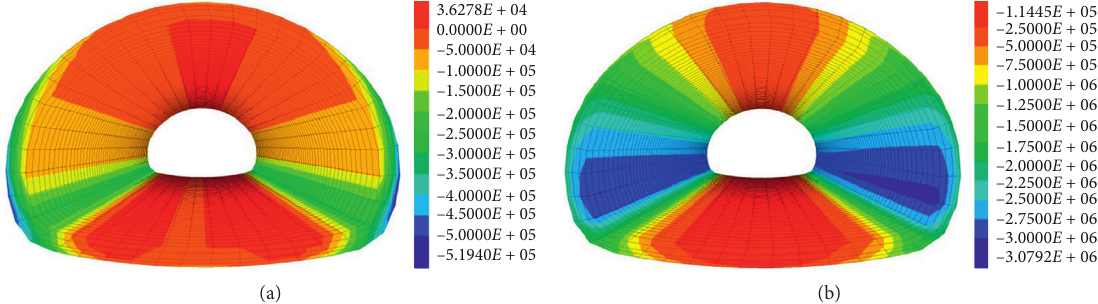
Figure 7: Lining structure stress of the first hole before blasting. (a) Maximum principal stress. (b) Minimum principal stress.